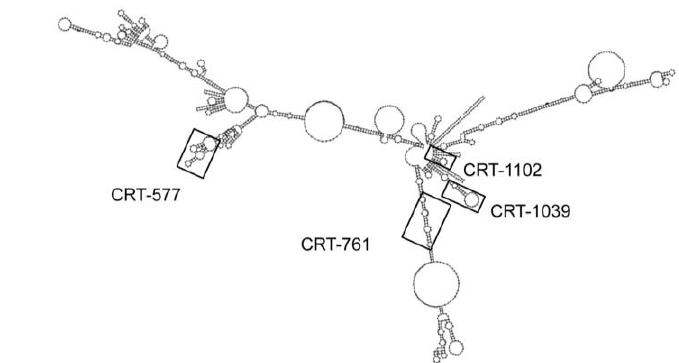
Figure 2. Localization of siRNA targeted regions on the predicted secondary structure of the Mi-CRT mRNA. Prediction of the calreticulin Mi-CRT complete mRNA secondary structure was obtained with RNAfold WebServer [24].